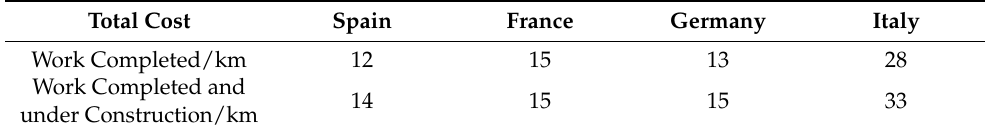
Table 4. Total cost of an HSR in Europe in millions of euro per kilometer